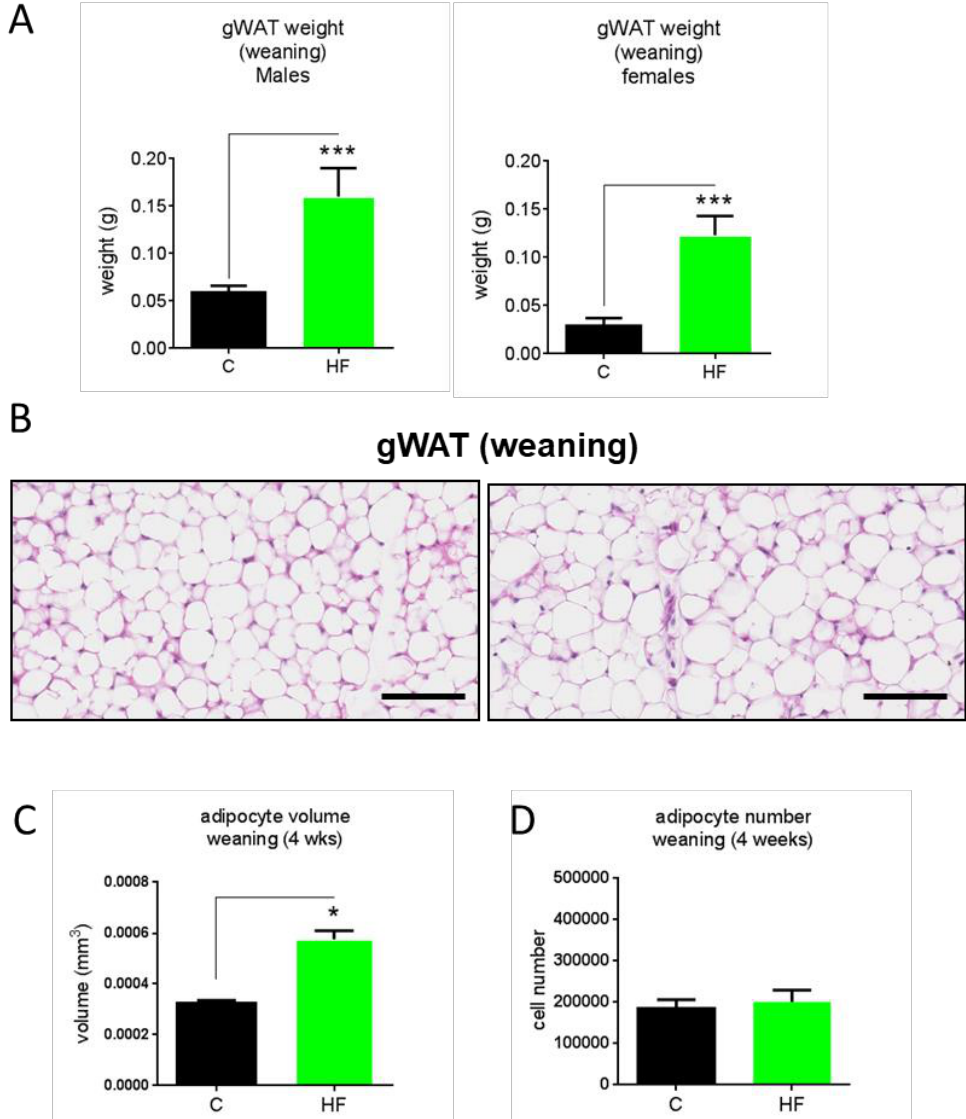
Figure 3. Gonadal white adipose tissue weights at weaning (4 weeks old) in male and female offspring ( A ), representative gWAT histological images (H&E stain), scale bars 50 µM ( B ), calculated adipocyte volume ( C ) and number ( D ) of dams fed a chow (C) or high-fat (HF) diet for 6 weeks prior to pregnancy and during pregnancy and lactation. N = 5. * p < 0.05, ** p < 0.01, *** p < 0.001, **** p < 0.0001.